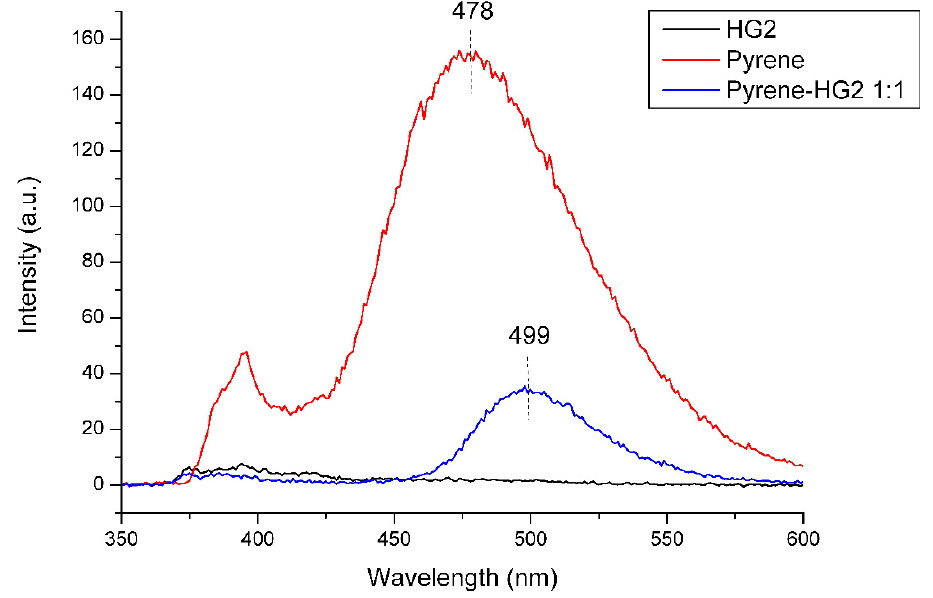
Figure 1. Fluorescence spectra of HG2, pyrene and HG2 pyrene molar ratio 1:1 at λ ex 338 nm.